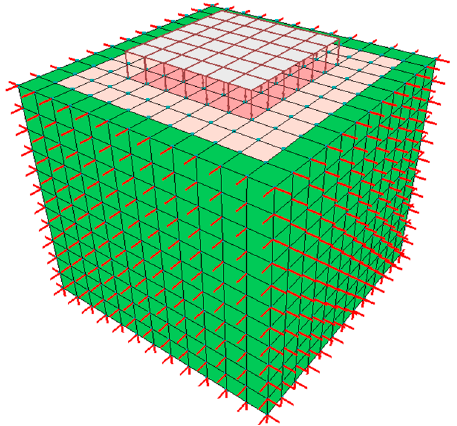
Figure 1. The FE model of the subsoil block, featuring the adopted indirect loading. The boundary conditions at the interface with the surrounding subsoil are reflected by an additional layer of elements whose Young’s modulus is E bc = 560 kPa and Poisson’s ratio is ν bc = 0.25, distinguished in green in Figure 1.